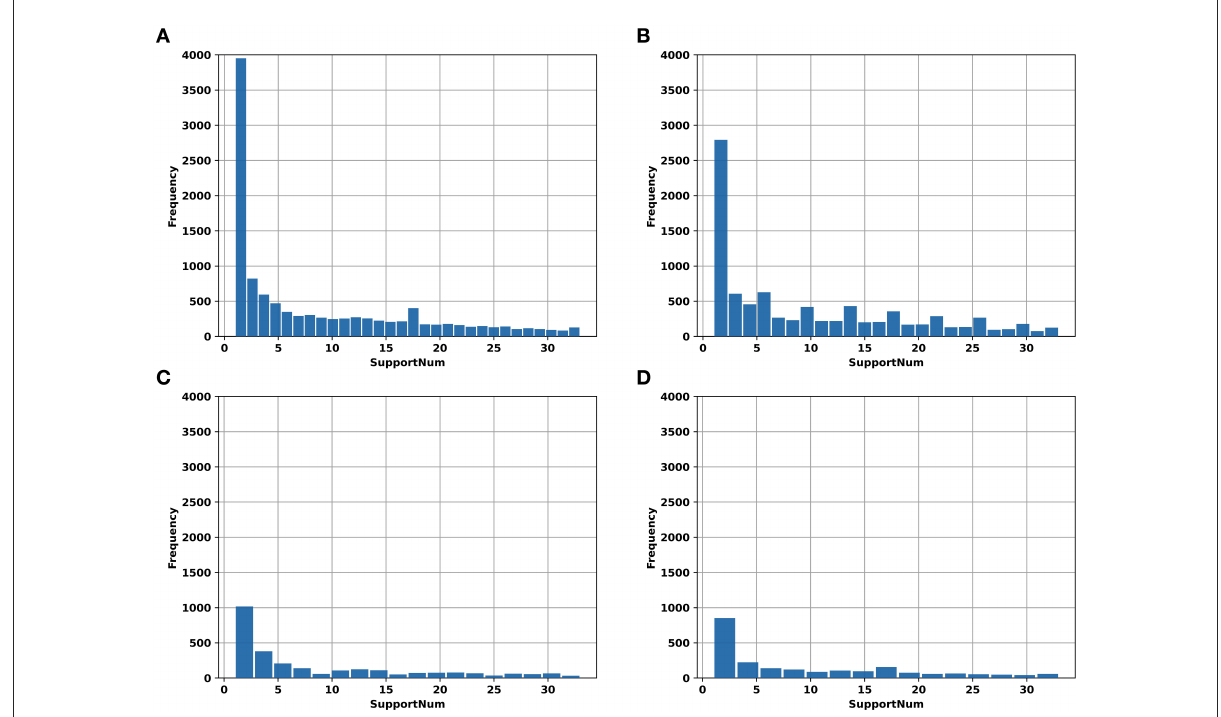
FIGURE1 The histogram of “SupportNum” on different datasets. (A) AAC_train; (B) GAC_train; (C) AAC_test; (D) GAC_test.